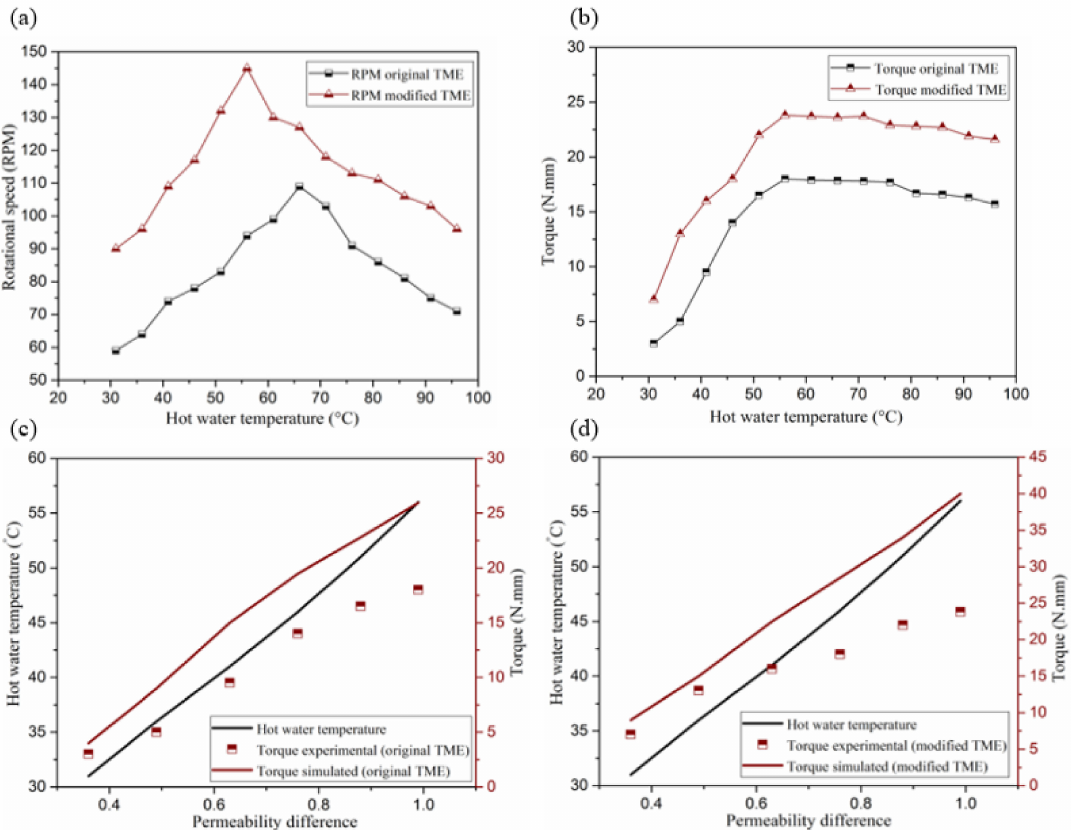
Figure 15. ( a ) Comparison of the rotational speed values between the original and modified configuration of the thermo- magnetic engine. ( b ) Comparison of torque values between the original and modified configuration of the thermomagnetic engine. ( c ) Comparison of the experimental and simulated values of torque for the original configuration of the heat engine. ( d ) Comparison of the experimental and simulated values of torque for the modified configuration of the heat